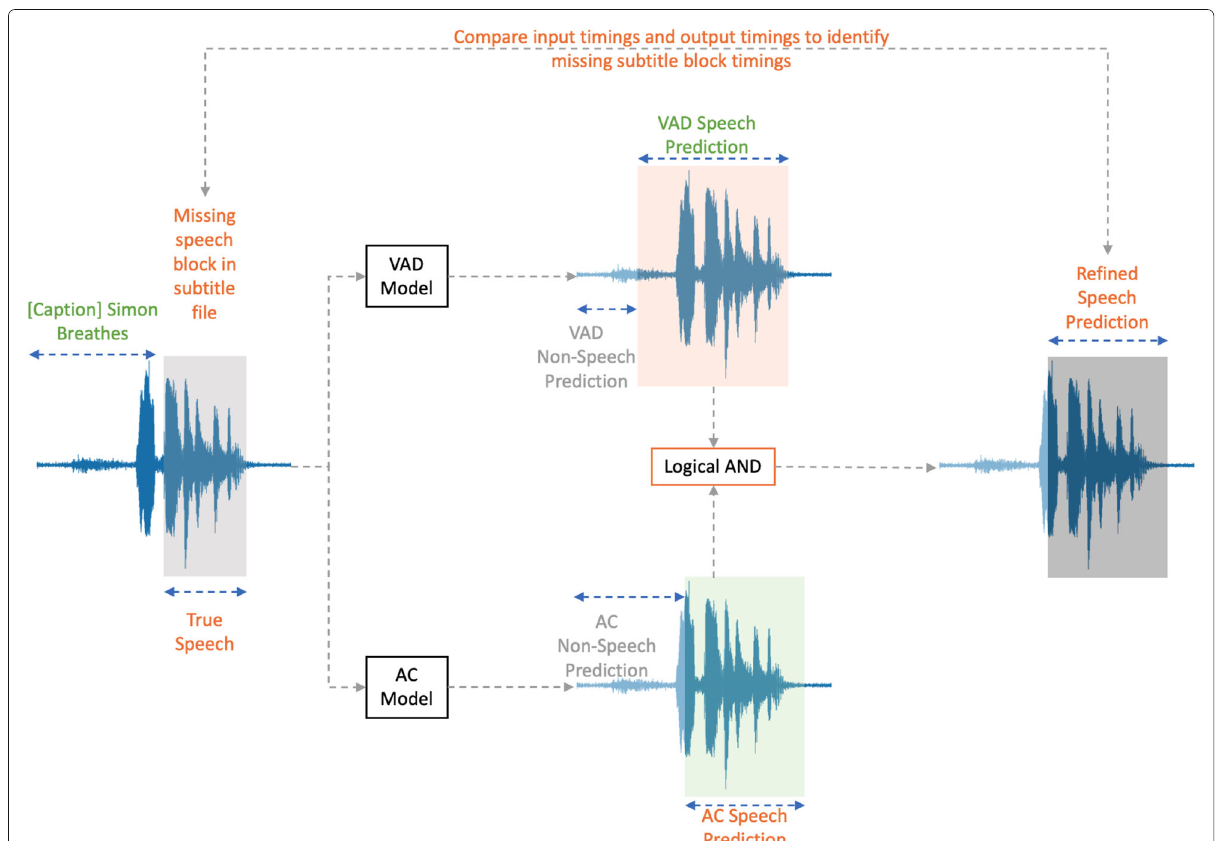
Fig. 4 Proposed method for combined VAD and AC inference and the algorithm to identify missing subtitle blocks. Consider the dialogue at the start which consists of a caption (Simon Breathes) and speech following it. However, this dialogue is missing from the subtitle file. To identify the true speech timings, we divide the audio in 800 ms (with 90% overlap) and 2 s clips (with no overlap) and pass them to VAD and AC models respectively. Following the VAD and AC timing generation step for the clips, we perform a logical AND between the timings and generate the refined predicted speech blocks. VAD can potentially identify the caption (Simon Breathes) as a speech block. The time duration associated with the caption is identified by the AC model and is removed from the VAD’s timing to generate the correct timings. We then compare the timings of predicted refined speech block to the timings present in the subtitle blocks and predict the missing subtitle